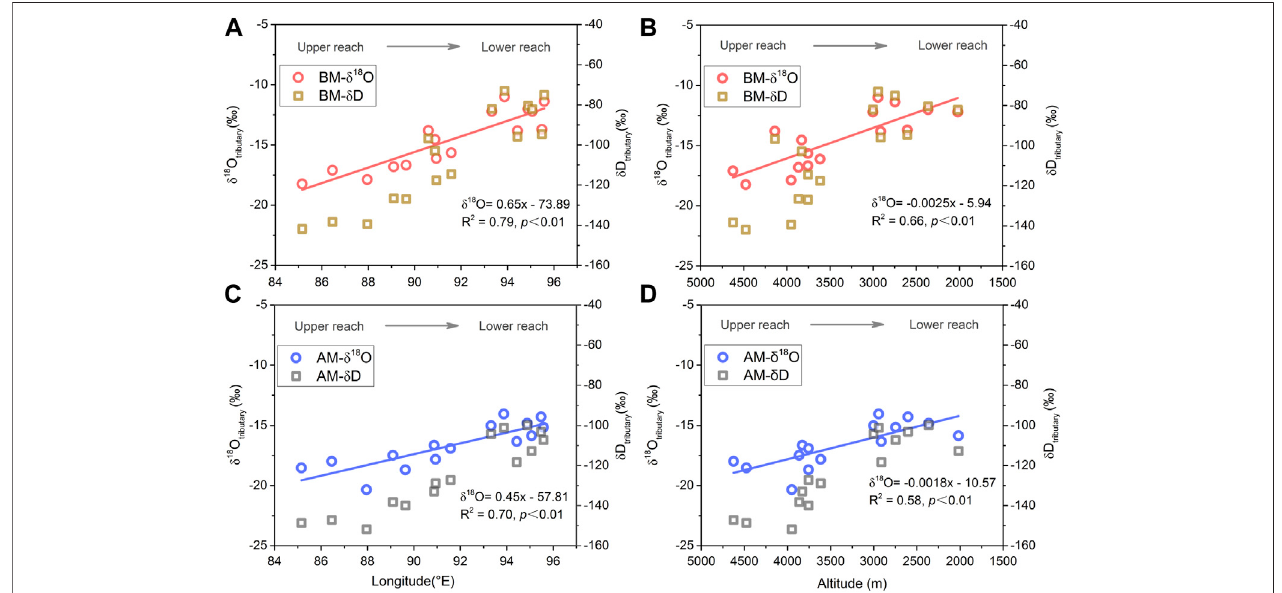
FIGURE 2 | Tributary water spatial variation of δ 18 O and δ D with longitude (A,C) and altitude (B,D) . Red circles and brown squares represent δ 18 O and δ D values beforemonsoonprecipitation(BM)in (A,B) ,respectively.Bluecirclesandgraysquaresrepresent δ 18 Oand δ Dvaluesaftermonsoonprecipitation(AM)in (C,D) .Redlines and blue lines show the linear fi tting relationships between δ 18 O in tributary water with longitude and altitude BM and AM, respectively.